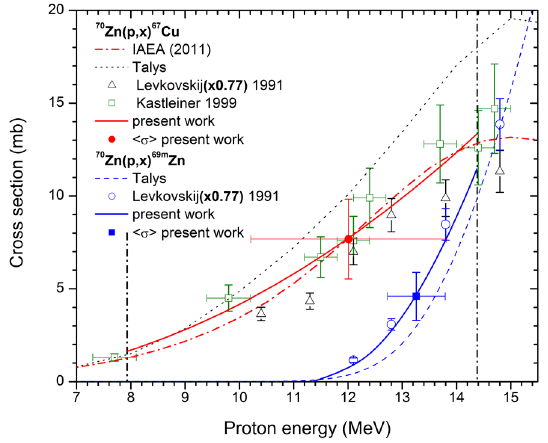
Fig. 3. (Color online) Experimental cross sections for 70 Zn(p,x) 67 Cu and 70 Zn(p,x) 69m Zn from Levkovskij et al . [19] and Kastleiner et al . [20] in comparison with theoretical predictions from the TENDL-2019 library [22], based on the TALYS code and the IEAE [21] recommended cross section for 67 Cu. The present work results for the average cross section associated with 67 Cu and 69m Zn production and the estimated cross section for the region are also